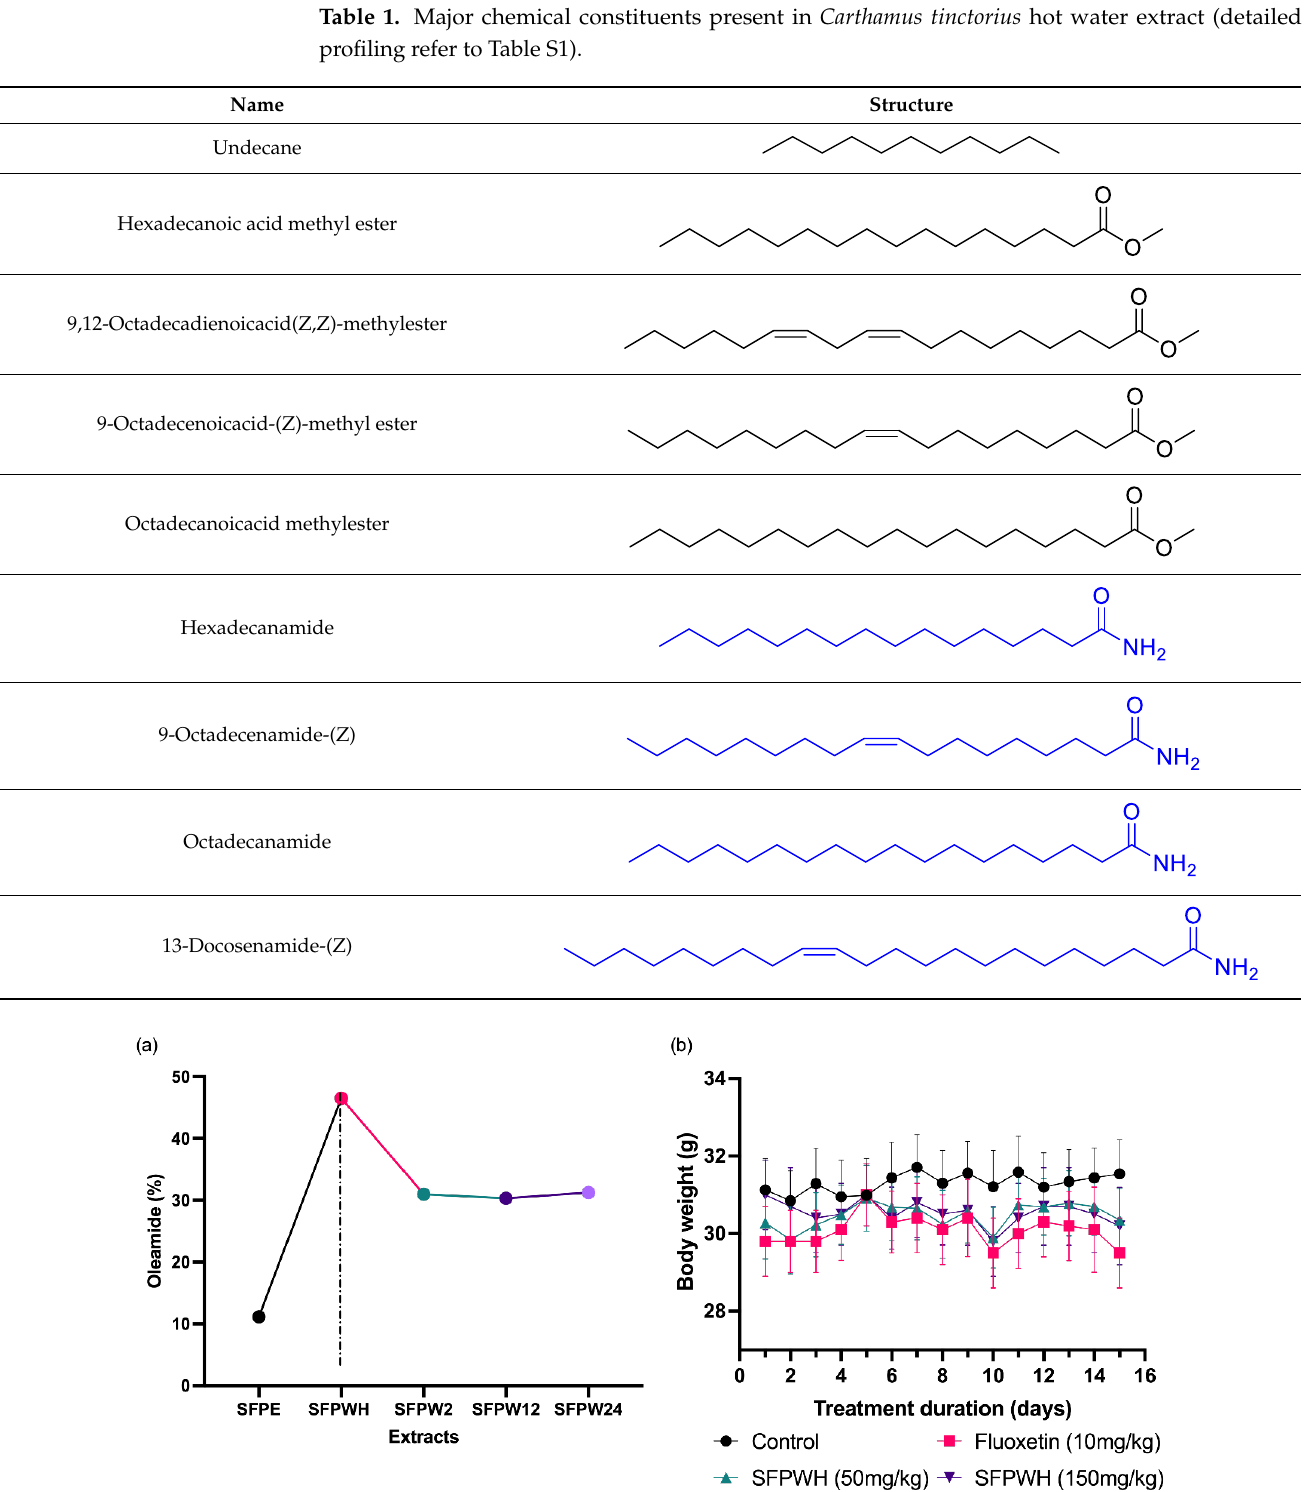
Figure 1. Characterization and efficacy of extracts. ( a ) Oleamide (CH 3 (CH 2 ) 7 CH=CH(CH 2 ) 7 CONH 2 (CID 5283387)) yield in Carthamus tinctorius extracts. (SFPE) 70% ethanol for 24 h, (SFPWH) hot water extraction, and (SFPW) the traditional method using maceration in water at room temperature for 2, 12, and 24 h. Oleamide (%) is reported as the percentage of the sum area in each extract. ( b ) Daily effect of safflower hot water extract treatment on body weight in depression-induced mice. Data represent the mean ± SEM (n = 8